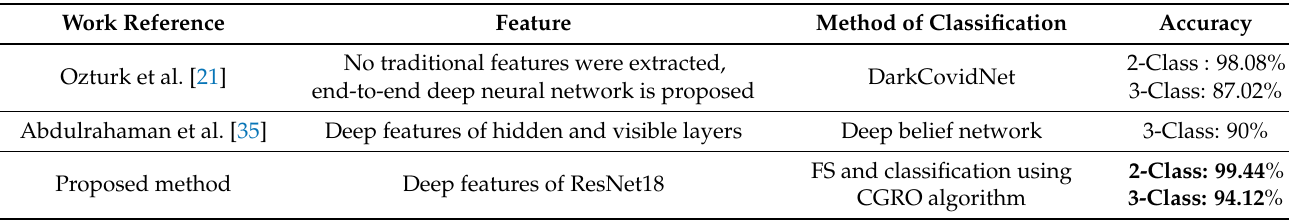
Table 12. Performance comparison of our proposed approach with some existing works for Chest X-Ray dataset of Muhammed Talo. Maximum value is